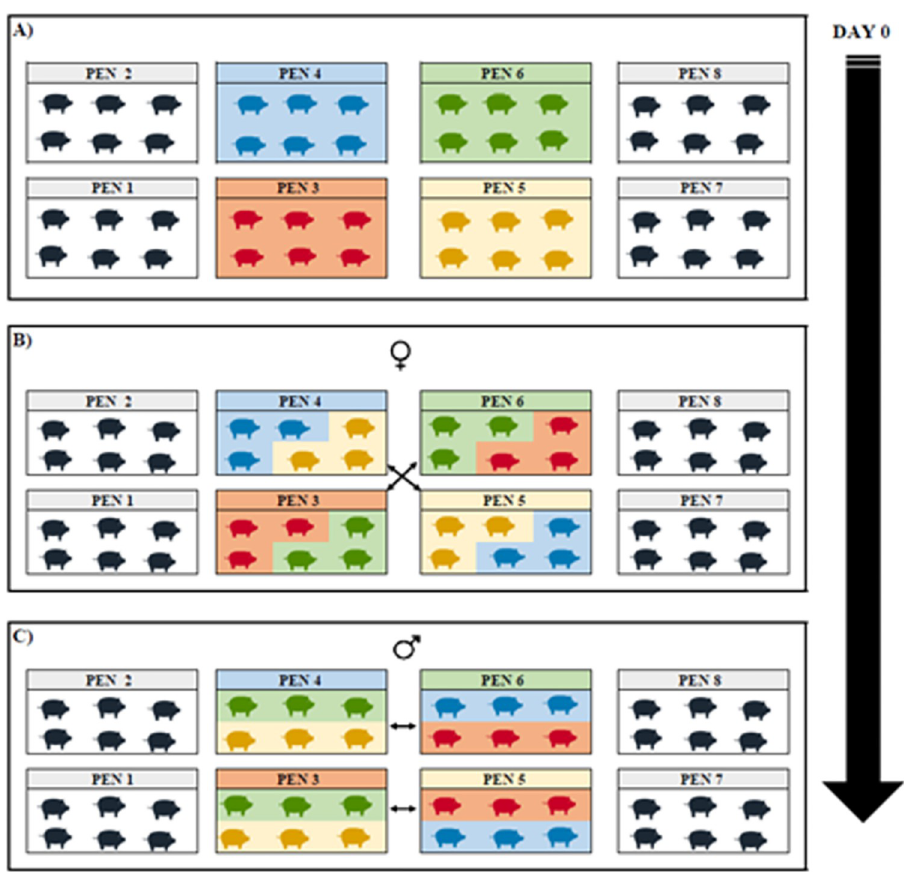
Fig 2. Stress factor related to the mixing scheme performed. A) Representation of the distribution performed at the beginning of the study (first mix). The gray pens represent the control group (pens 1, 2, 7 and 8). The colored pens represent the stress group (pens 3, 4, 5 and 6). B) Mix of females–representation of the second mix performed. The females in pen 3 switched places with the females in pen 6. The females in pen 4 switched places with the females in pen 5. The barrow group remained unchanged in all pens. C) Mix of barrows–representation of the third mix performed. The barrows in pen 3 switched places with the barrows in pen 5. The barrows in pen 4 switched places with the barrows in pen